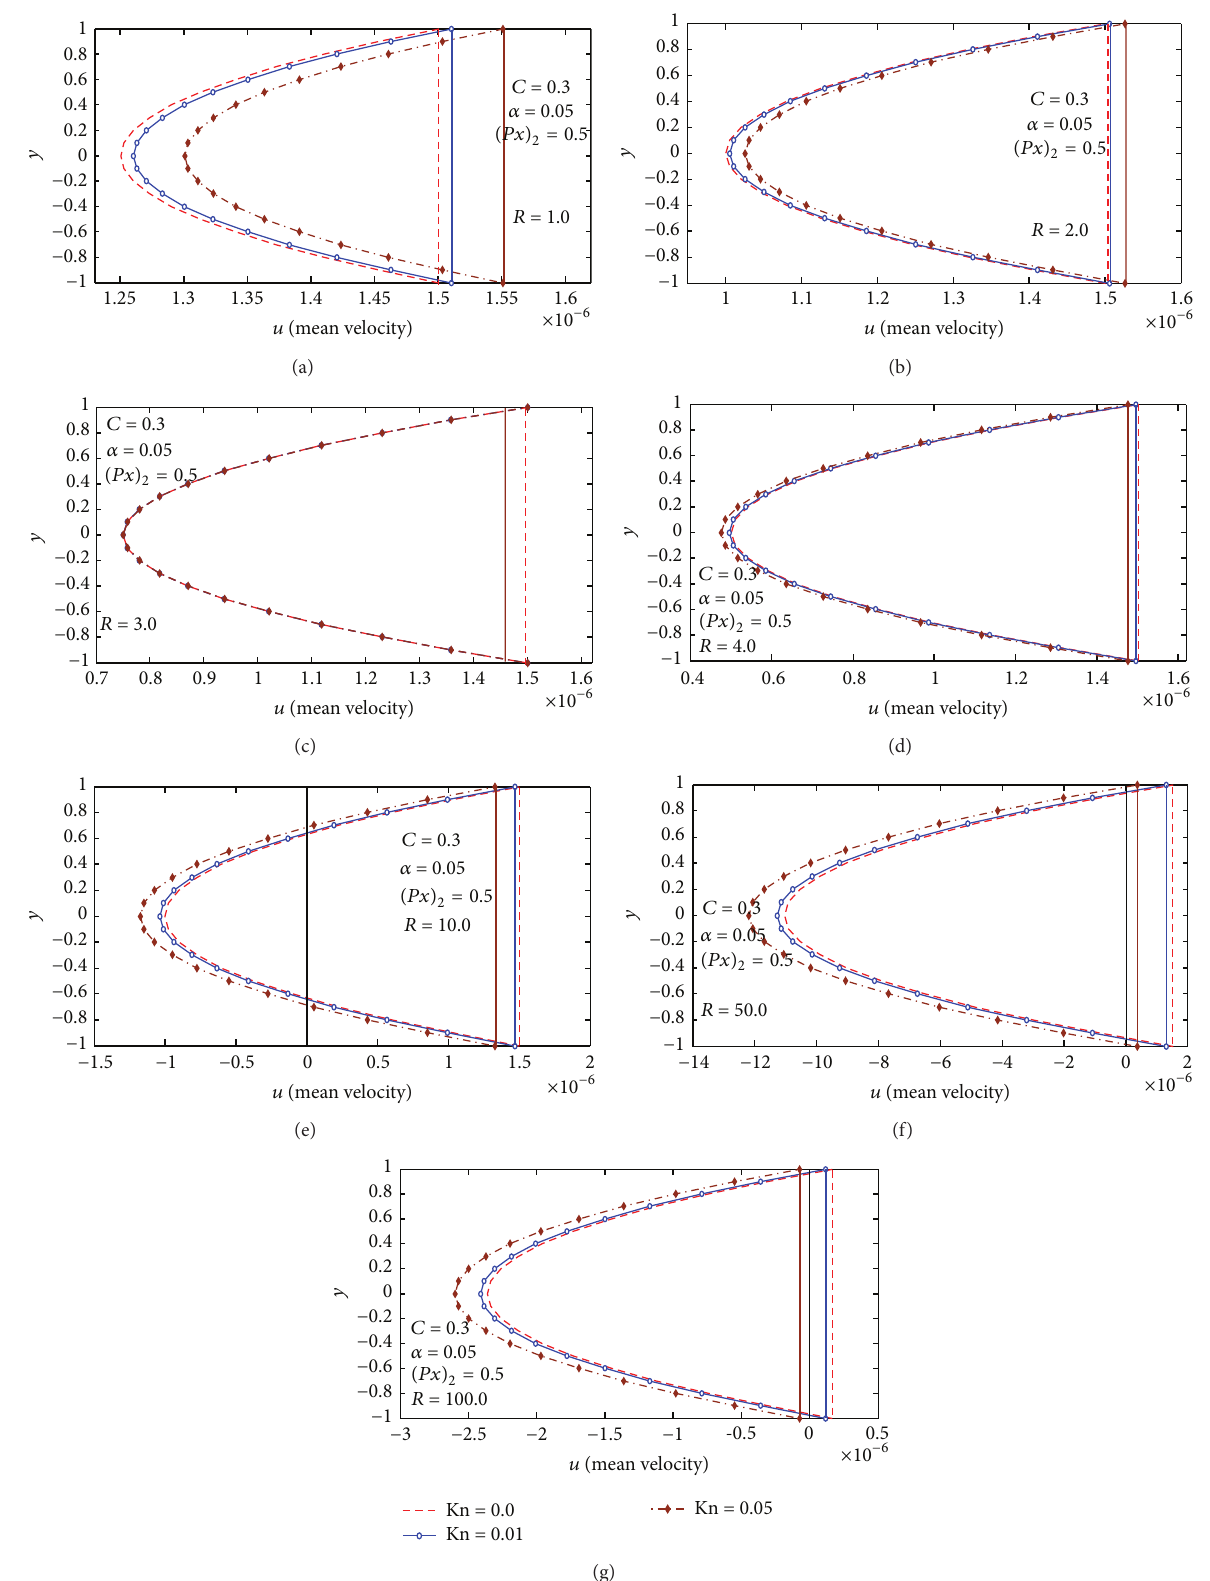
Figure 5: (a) Mean velocity distribution at 𝑅 = 1.0 , 𝛼 = 0.05 , (𝜕𝑝/𝜕𝑥) 2 = 0.5, and 𝐶 = 0.3 . (b) Mean velocity distribution at 𝑅 = 2.0 , 𝛼 = 0.05 , = 0 .5 , and 𝐶 = 0.3 . (c) Mean velocity distribution at 𝑅 = 3.0 , 𝛼 = 0.05 , (𝜕𝑝/𝜕𝑥) ( 𝜕𝑝/𝜕𝑥) 2 at 𝑅 = 4.0 , 𝛼 = 0.05 , (𝜕𝑝/𝜕𝑥) 2 = 0 .5 , and 𝐶 = 0.3 . (e) Mean velocity distribution at 𝑅 = 10.0 , 𝛼 = 0.05 , (𝜕𝑝/𝜕𝑥) 2 = 0 .5 , and 𝐶 = 0.3 . (f) Mean velocity distribution at 𝑅 = 50.0 , 𝛼 = 0.05 , (𝜕𝑝/𝜕𝑥) 2 = 0 .5 , and 𝐶 = 0.3 . (g) Mean velocity distribution at 𝑅 = 100.0 , 𝛼 = 0.05 , (𝜕𝑝/𝜕𝑥) 2 = 0 .5 , and 𝐶 = 0.3